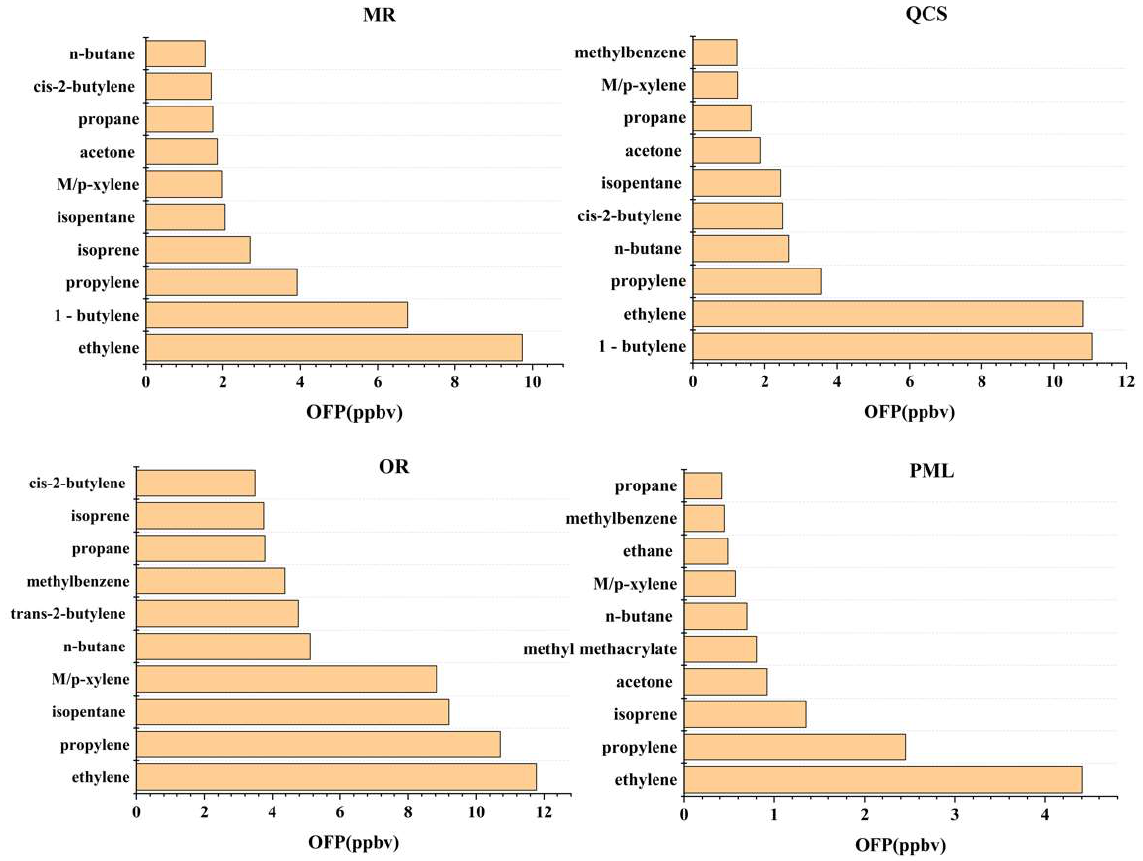
Figure 7. Top 10 volatile organic carbon by ozone formation potential rankings at each site.